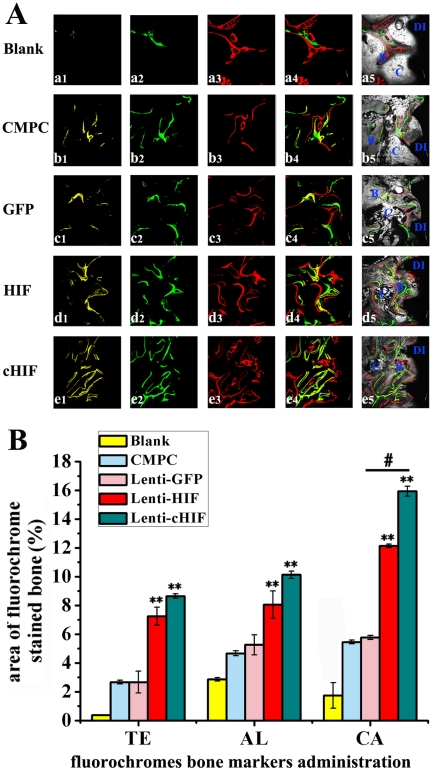
New bone formation and mineralization determined histomorphometrically by TE, CA, and AL fluorescent quantification, which represent the mineralization level at 12 weeks after the operation (A).Parts a, b, c, d, and e are confocal laser scanning microscopy images for each group. Parts a4, b4, c4, d4, and e4 represent merged images of the three fluorochromes for the same group. Parts a5, b5, c5, d5, and e5 represent the merged images of the three fluorochromes together with the plain confocal laser microscopy image for the same group. (B) The graph shows the percentage of each fluorochrome area in each group. (** P<0.01, target gene groups compared with the GFP group, Blank group or CMPC group; #, P<0.05, the cHIF group compared to the HIF group).